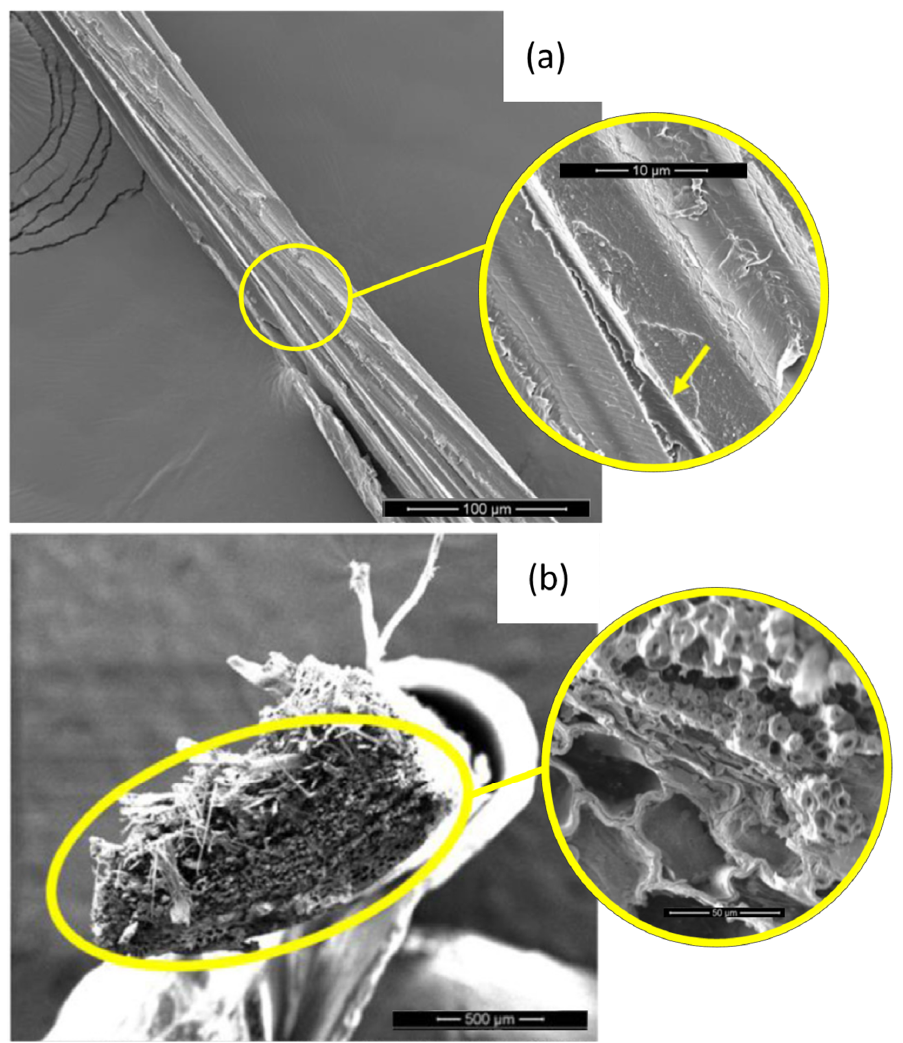
Figure 2. SEM images of a guaruman fiber: ( a ) lateral view with microfibrils, and ( b ) cross-section with large holes and cylindrical microfibrils. Adapted from [22].